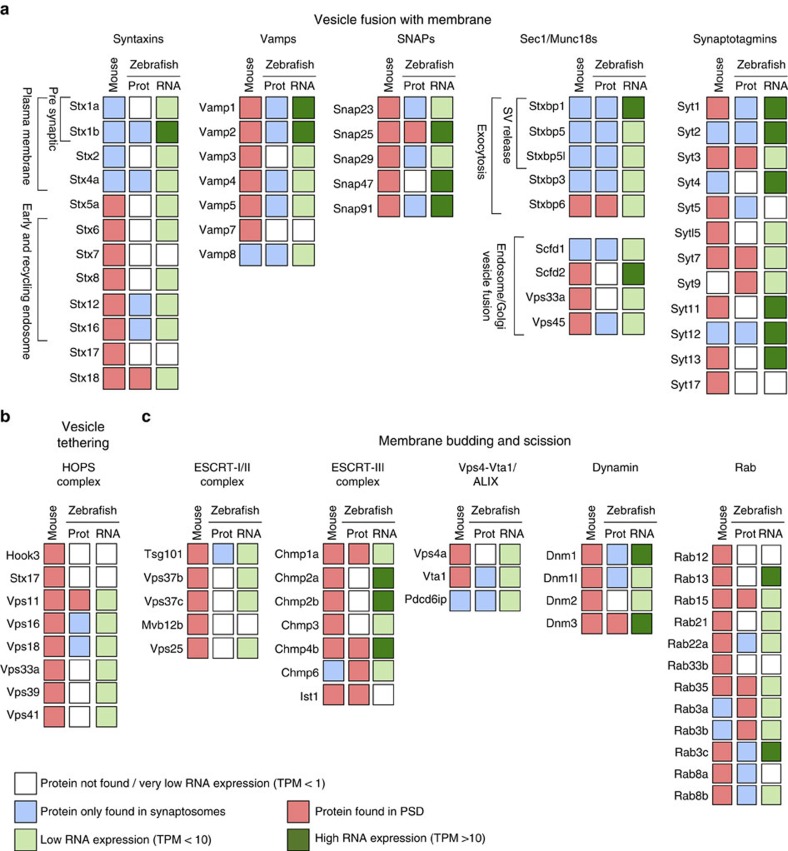
Differential expression of PSD proteins involved in intracellular vesicle biogenesis between mouse and zebrafish.For each protein the mouse orthologue gene name is given. Proteomic data are provided for both species. For proteomic data, a white square denotes that we did not detect that protein, a blue square identifies proteins found in synaptosomes but not in PSDs and a red square identifies proteins found at the PSD. The average mRNA expression (mean transcripts per million (TPM) from four whole-brain biological replicates) was determined for each gene (for TPMs of individual samples, see Supplementary Fig. 10). For mRNA-sequencing data, a white box denotes a mean expression of <1 TPM, a pale green box <10 TPM and dark green >10 TPM. (a) Proteins involved in vesicle fusion with membranes, including SNARE complex proteins: Syntaxins, Vamps and SNAPs, syntaxin-binding proteins (Sec1/Munc18) and Synaptotagmins. (b) Proteins form the HOPS complex involved in membrane vesicle tethering to membranes. (c) Proteins involved in membrane bending/budding and scission to form vesicles, including proteins from ESCRT complexes (ESCRT I, II, III and Vps4-Vta1/ALIX), Dynamins and small GTPases from the Rab family.